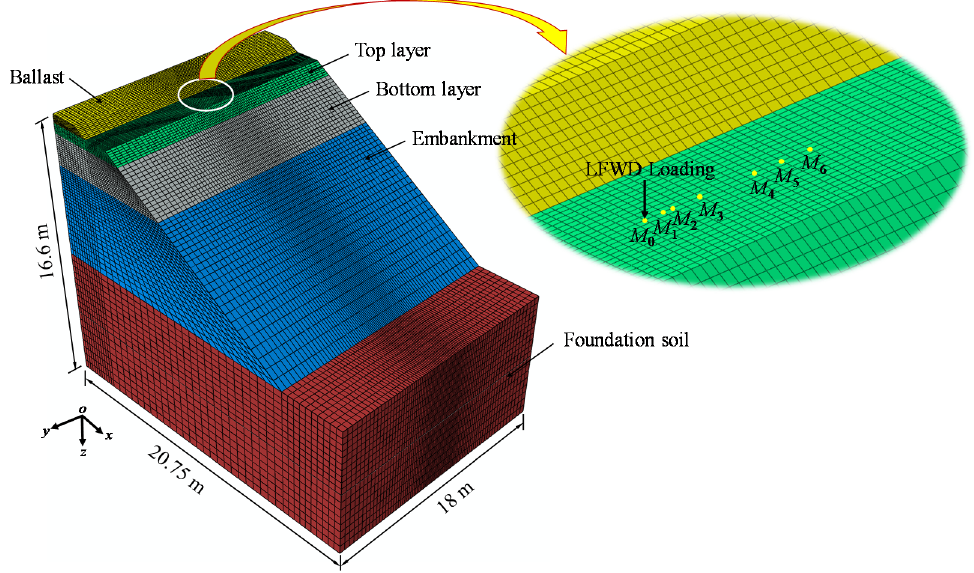
Figure 3. Track model for LFWD inverse analysis.